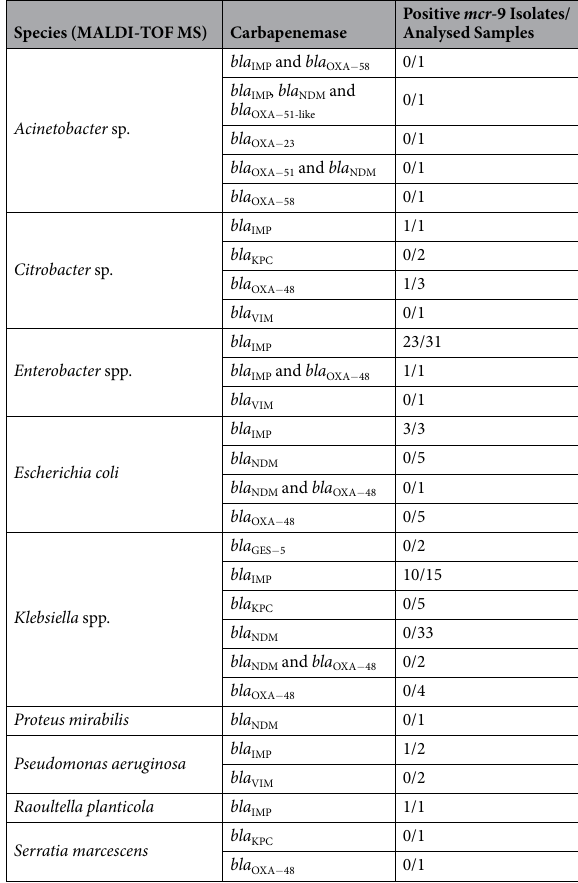
Table 1. Clinical carbapenemase-producing organisms analysed by the mcr − 9 LAMP assay. All isolates were negative for mcr − 1 to 8 by qPCR and whole genome sequencing. A detailed description of each isolate, including bacterial species, date of sampling, specimen type, its origin, antibiotic resistance mechanisms, TTP obtained by the mcr − 9 LAMP, and WGS results can be found in Tables S2 and